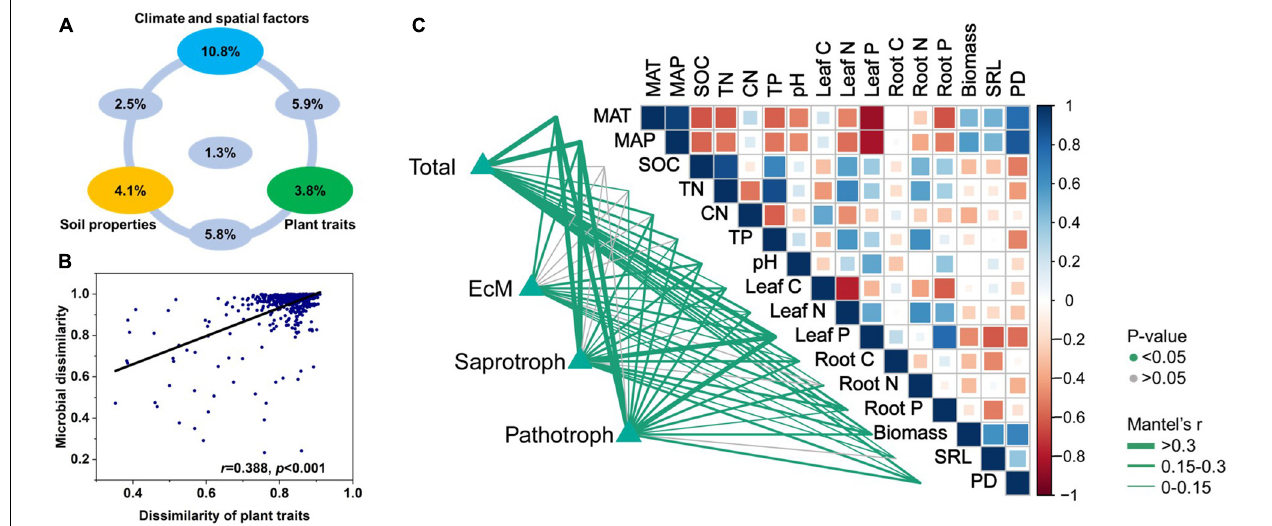
FIGURE 5 | (A) Variation partitioning modeling identifying relative contributions of plant traits, climatic and spatial factors, and soil properties as predictors of soil fungal community composition at OTU level. (B) Relationship between Bray-Curtis community dissimilarity and Euclidean distance matrix for plant traits. Each data point represents Bray-Curtis dissimilarity score for two samples and Euclidean distance between them. (C) Environmental variables correlated with total and major functional fungal community structures in nine forest ecosystems. Correlations and significance were determined by Mantel tests based on 999 permutations.